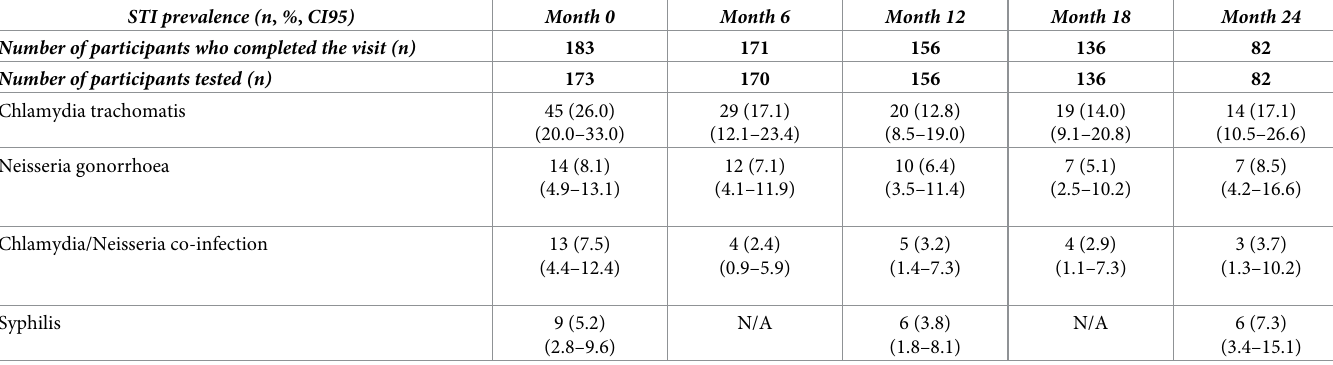
Table 2. STI prevalence over time of enrolled MSM participants with available STI testing data. STI prevalence (n , % , CI95) Month 0 Month 6 Month 12 Month 18 Month 24 Number of participants who completed the visit (n) 183 171 156 Number of participants tested (n) 173 Chlamydia